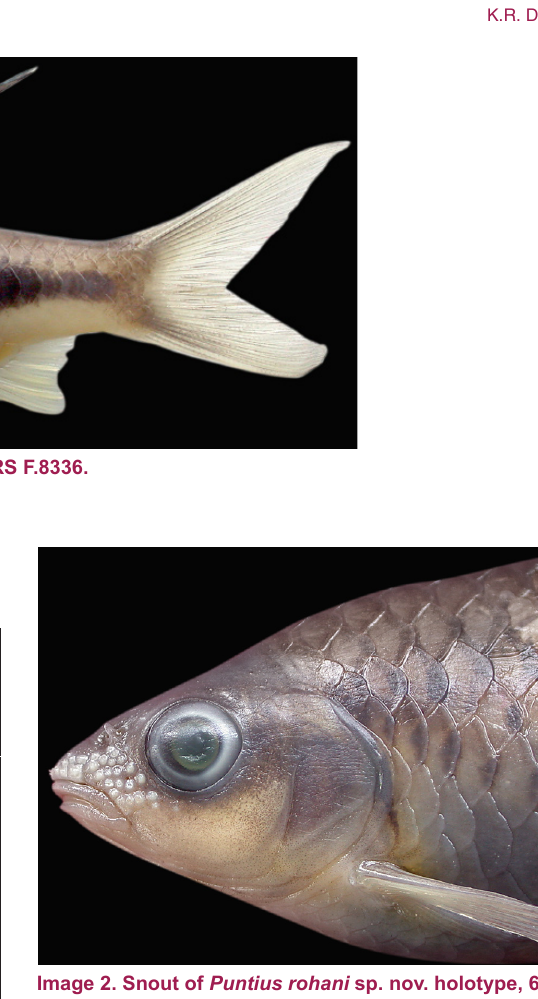
pattern of a black club-shaped blotch 1.5 scales high extending from the 12-13 th lateral-line scales to the caudal-fin base, the absence of any other body colour pattern anterior to it (vs. presence in P. arulius (Image 3K), P. tambraparniei (Images 3F,G) , P. srilankensis and P. exclamatio (Image 3H)), and the absence of a transverse black band near the tip of each caudal-fin lobe (vs.